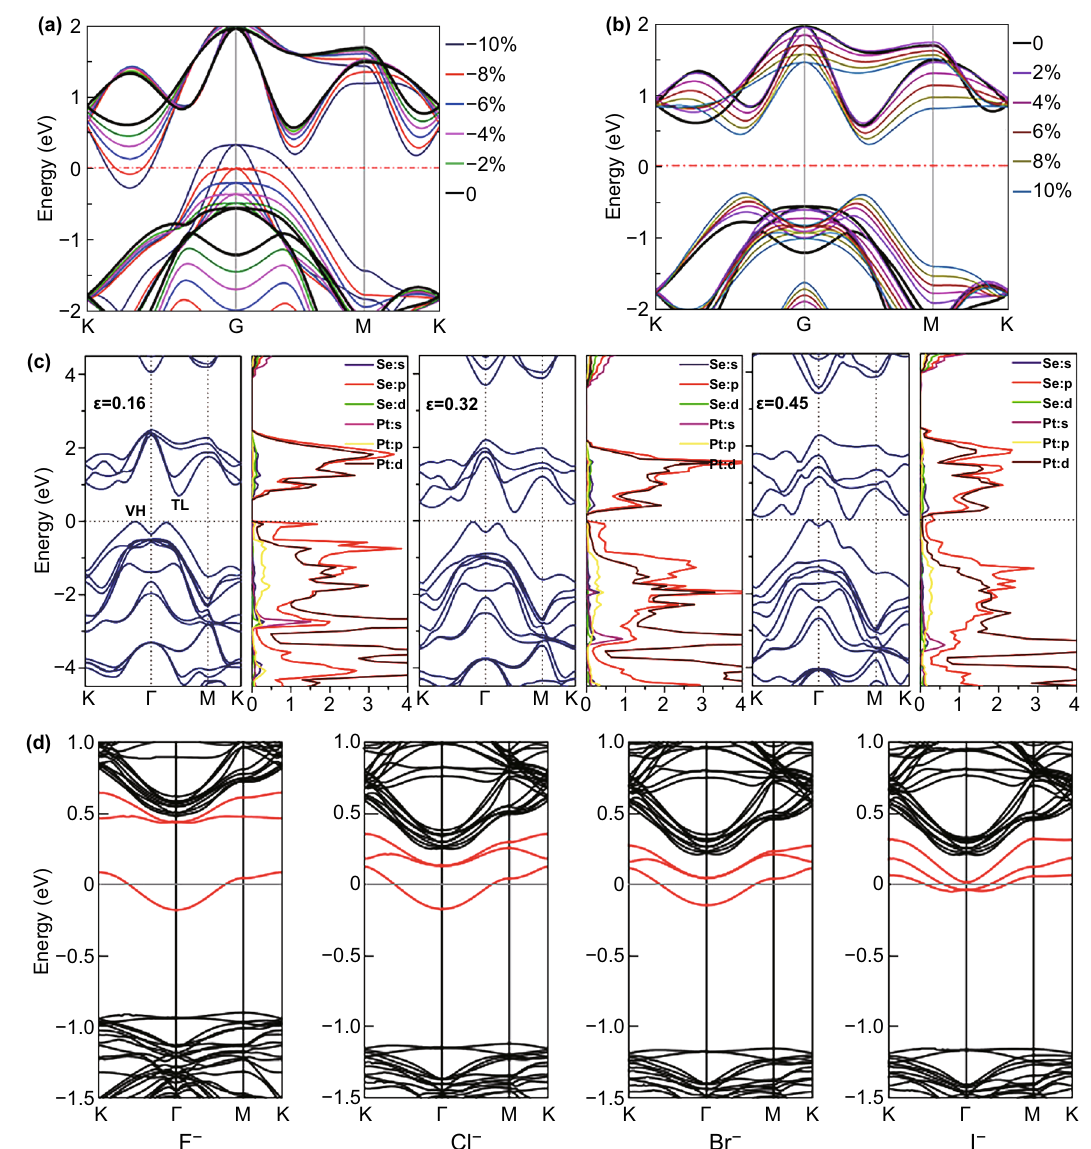
Fig. 3 Band structure engineering of PtSe 2 . Computed band structure of the monolayer PtSe 2 with symmetrical biaxial compressive ( a ) and ten‑ sile strains ( b ). Reproduced with permission [65]. Copyright 2018, American Chemical Society. c Band structure and density of state of bilayer PtSe 2 under vertical compressive strain ( ε = 0.16, 0.32, and 0.45). Reproduced with permission [52]. Copyright 2016, American Chemical Soci‑ ety. d Computed band structure of the F‑doped, Cl‑doped, Br‑doped, and I‑doped monolayer PtSe 2 . Reproduced with permission [36]. Copyright 2018, American Physical